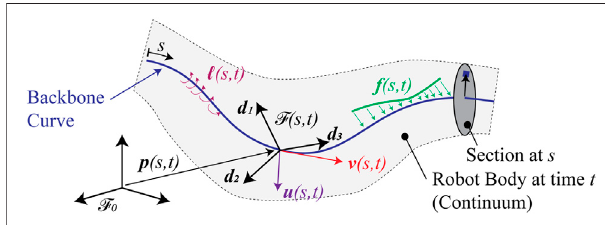
FIGURE 2 | Mathematical setup of the curve-based kinematic description of slender continuum